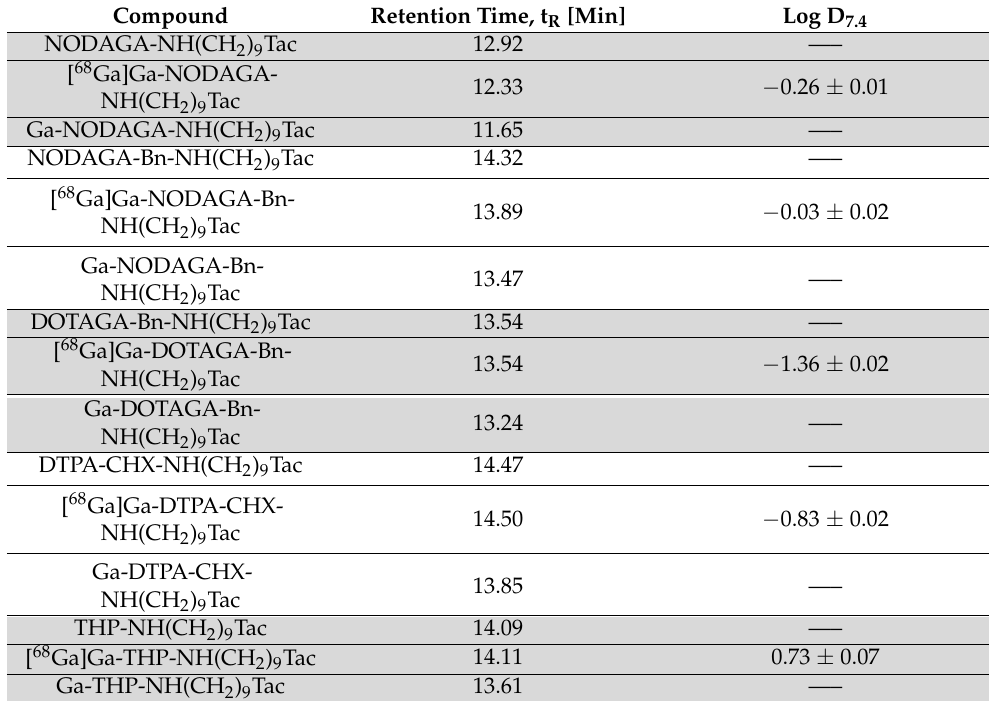
Figure 1. Chemical structures of the developed and investigated radioconjugates: ( A )—[ 68 Ga]Ga ‐ NODAGA ‐ NH(CH 2 ) 9 Tac, ( B )—[ 68 Ga]Ga ‐ NODAGA ‐ Bn ‐ NH(CH 2 ) 9 Tac,